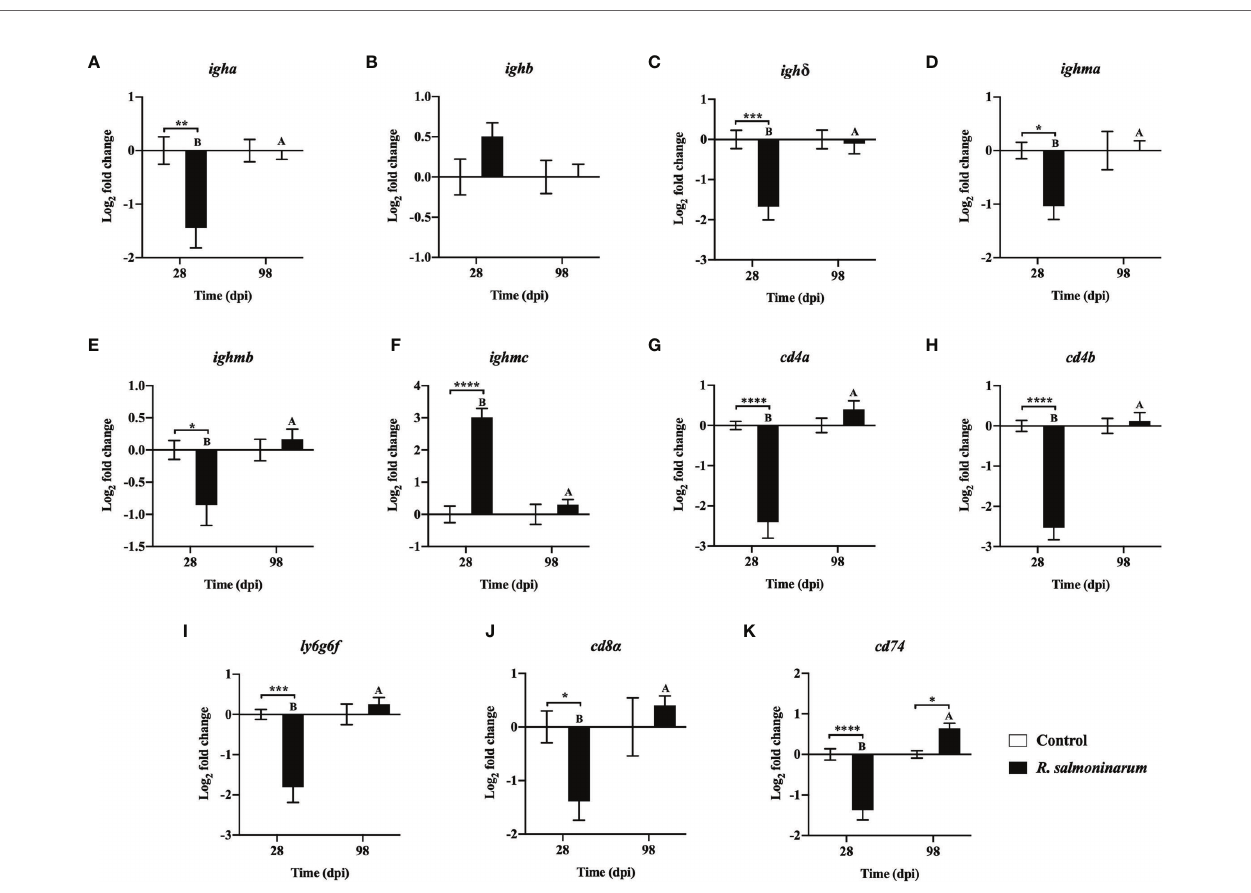
FIGURE 6 | Expression of transcripts related to humoral (A – F) and cellular mediated (G – K) immunity in lump fi sh head kidney in response to R. salmoninarum infection at 28 and 98 days post infection (dpi). Transcript expression levels in head kidney from control (PBS-mock infected group) and infected [high dose (1×10 9 cells/dose) of R. salmoninarum ] lump fi sh at 28 and 98 dpi were analyzed using qPCR. Relative expression was calculated using the 2 − DD Ct method and log2 transformed; etif3d and pabpc1b were the endogenous control genes. A two-way ANOVA test, followed by the Sidak multiple comparisons post hoc test was used to identify signi fi cant differences between treatments (control and infected groups) at a single time point, and for a given treatment at different time points (28 and 98 dpi). Asterisks (*) represent signi fi cant differences between treatments at each time-point (* p < 0.05, ** p < 0.01, *** p < 0.001, **** p < 0.0001). Different letters represent signi fi cant differences between control (lower case) and infected (upper case) groups at 28 compared to 98 dpi. Each value is the mean ± S.E.M ( n =